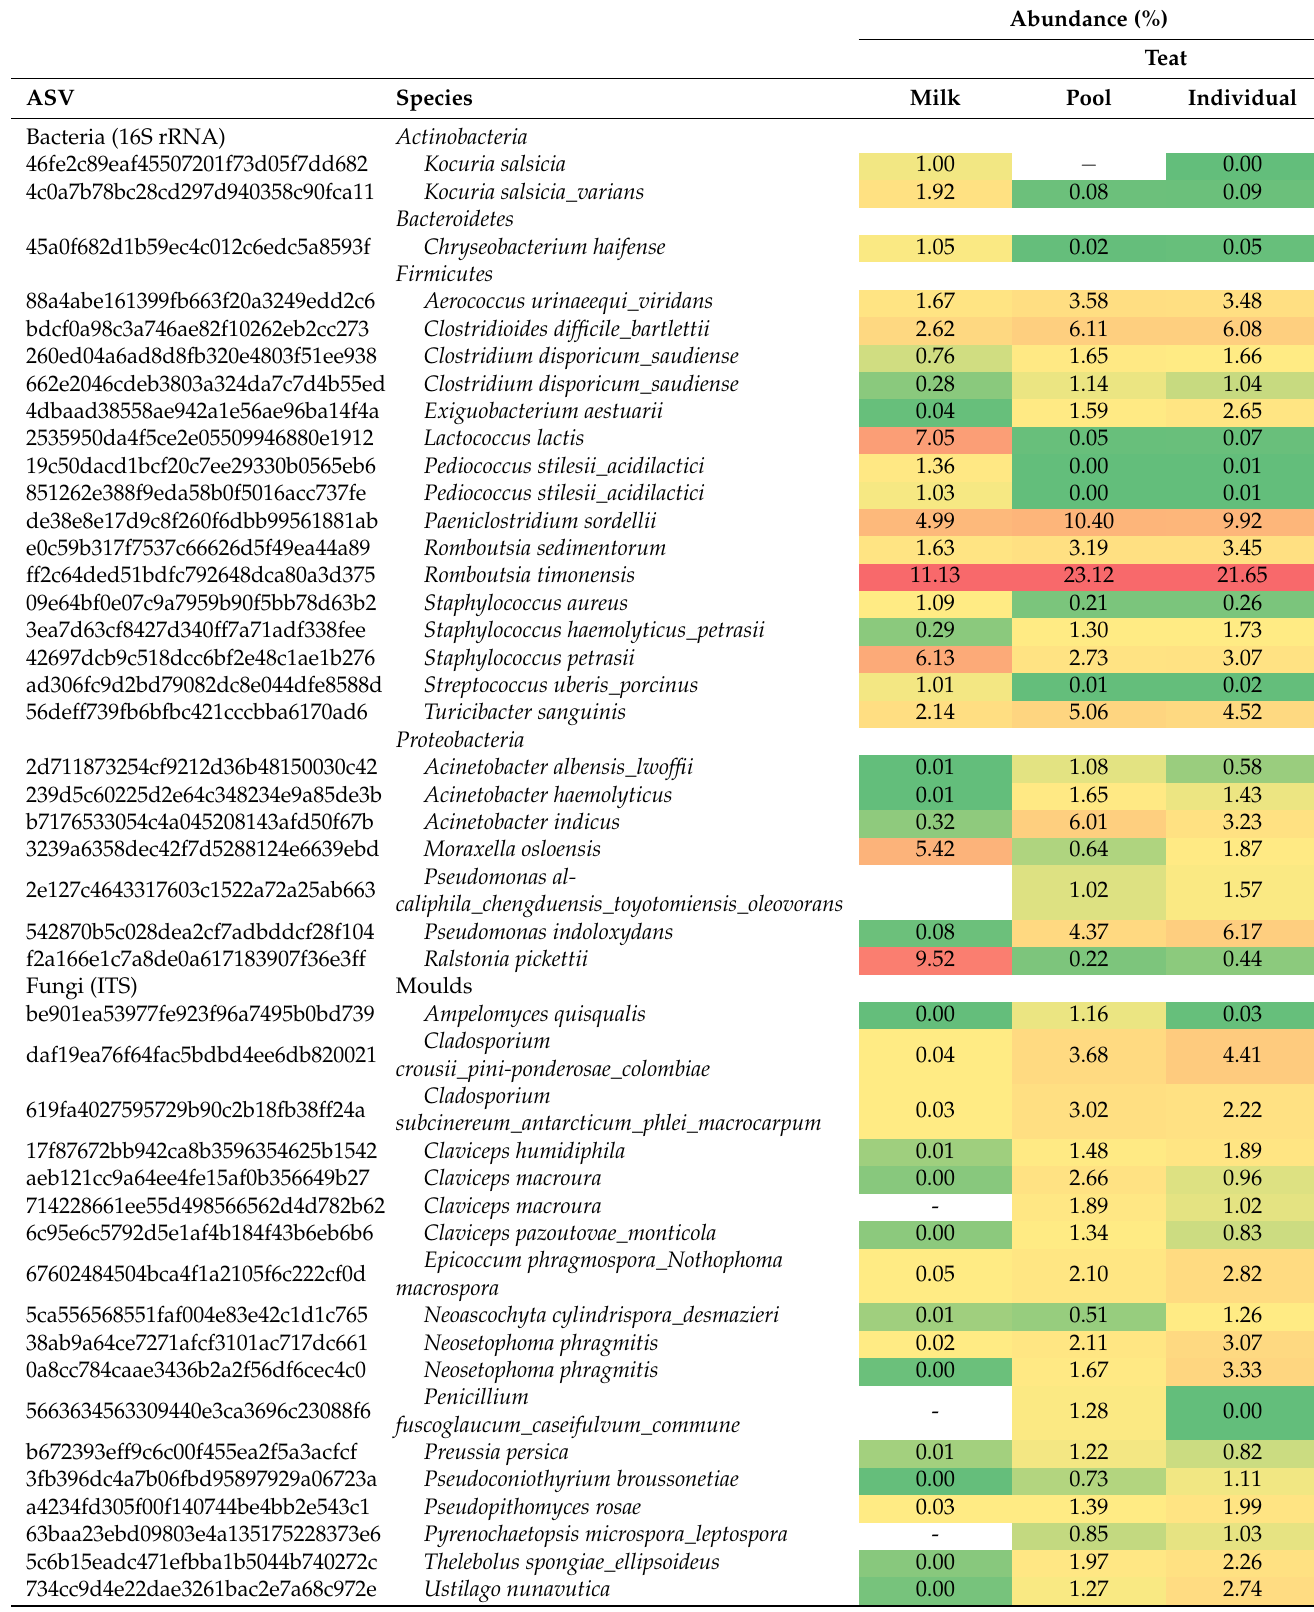
Table 5. Bacterial and fungal ASVs with mean abundance above 1% of the total sequences in milks and in the pooled and individual teat suspensions.